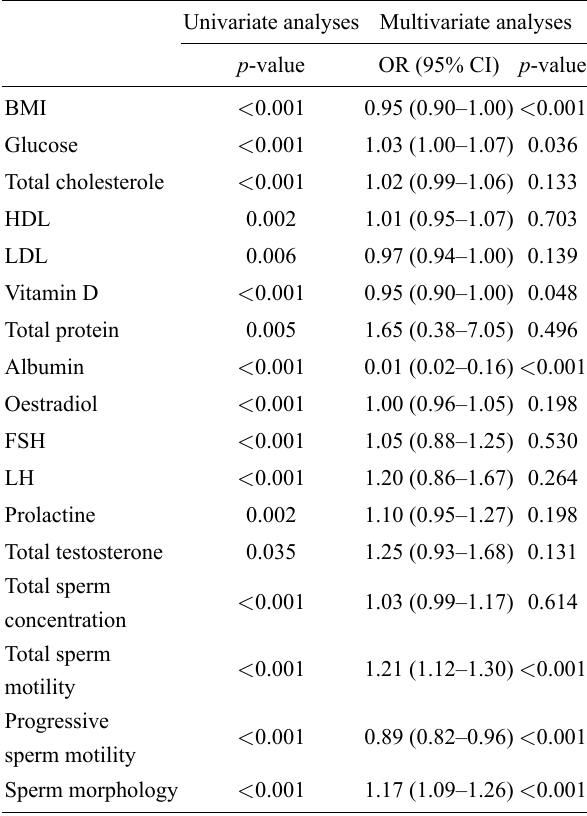
Table 4. Univariate and Multivariate analyse results of the groups, after age, smoking and BMI were adjusted as confounding